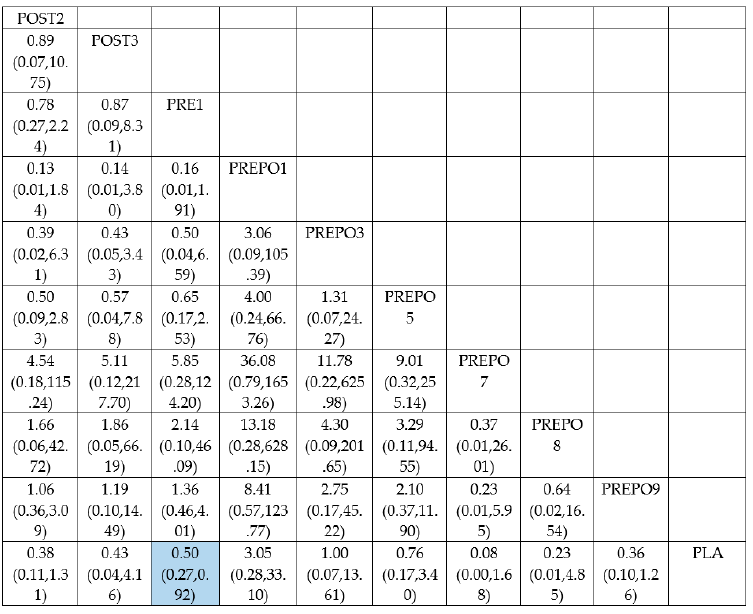
Figure 6. League table for implant failure (per implant).